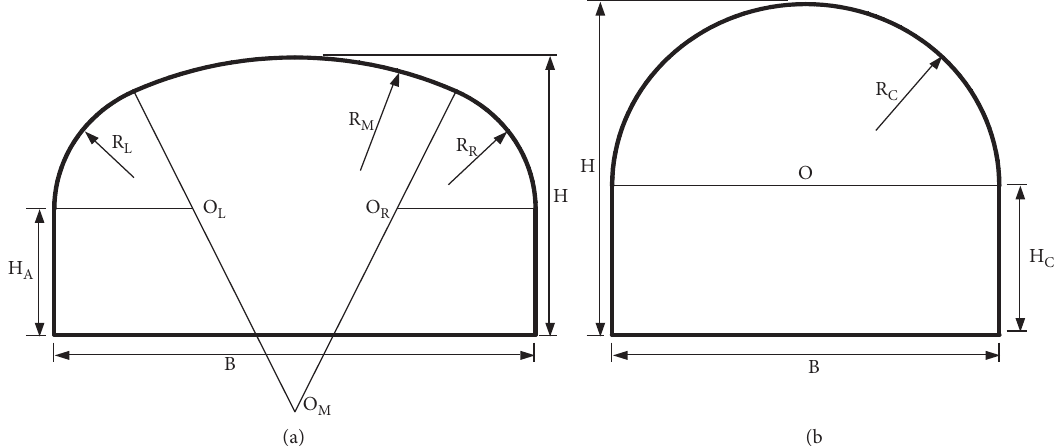
Figure 3: Section composition of two tunnel sections. (a) An arched section and (b) a circular arched